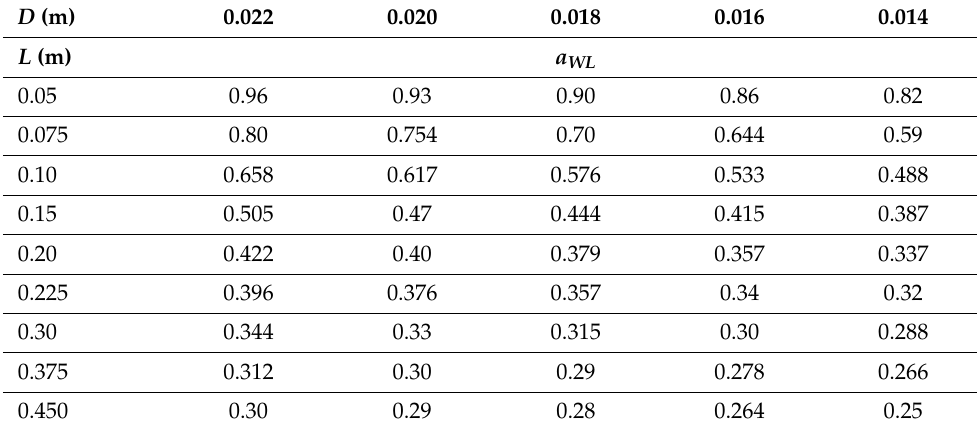
Table 3. Thermal conductivity coefficient a WL versus pipe spacing L , outer diameter D , and character-